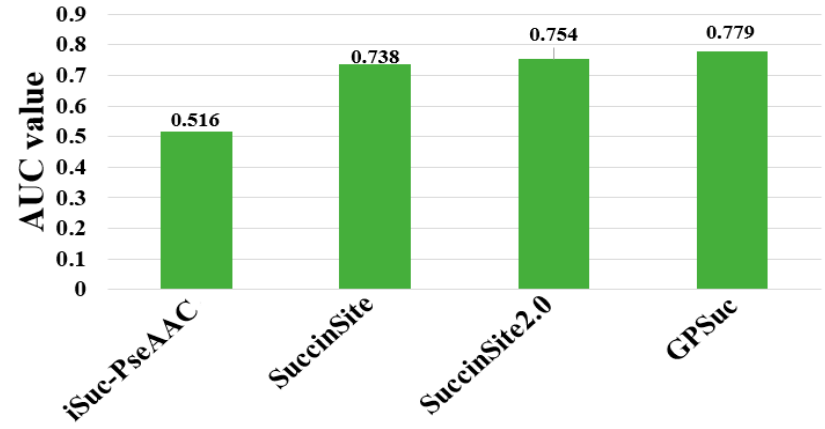
Figure 4. Performance comparison of generic succinylation site prediction models on an independent dataset.